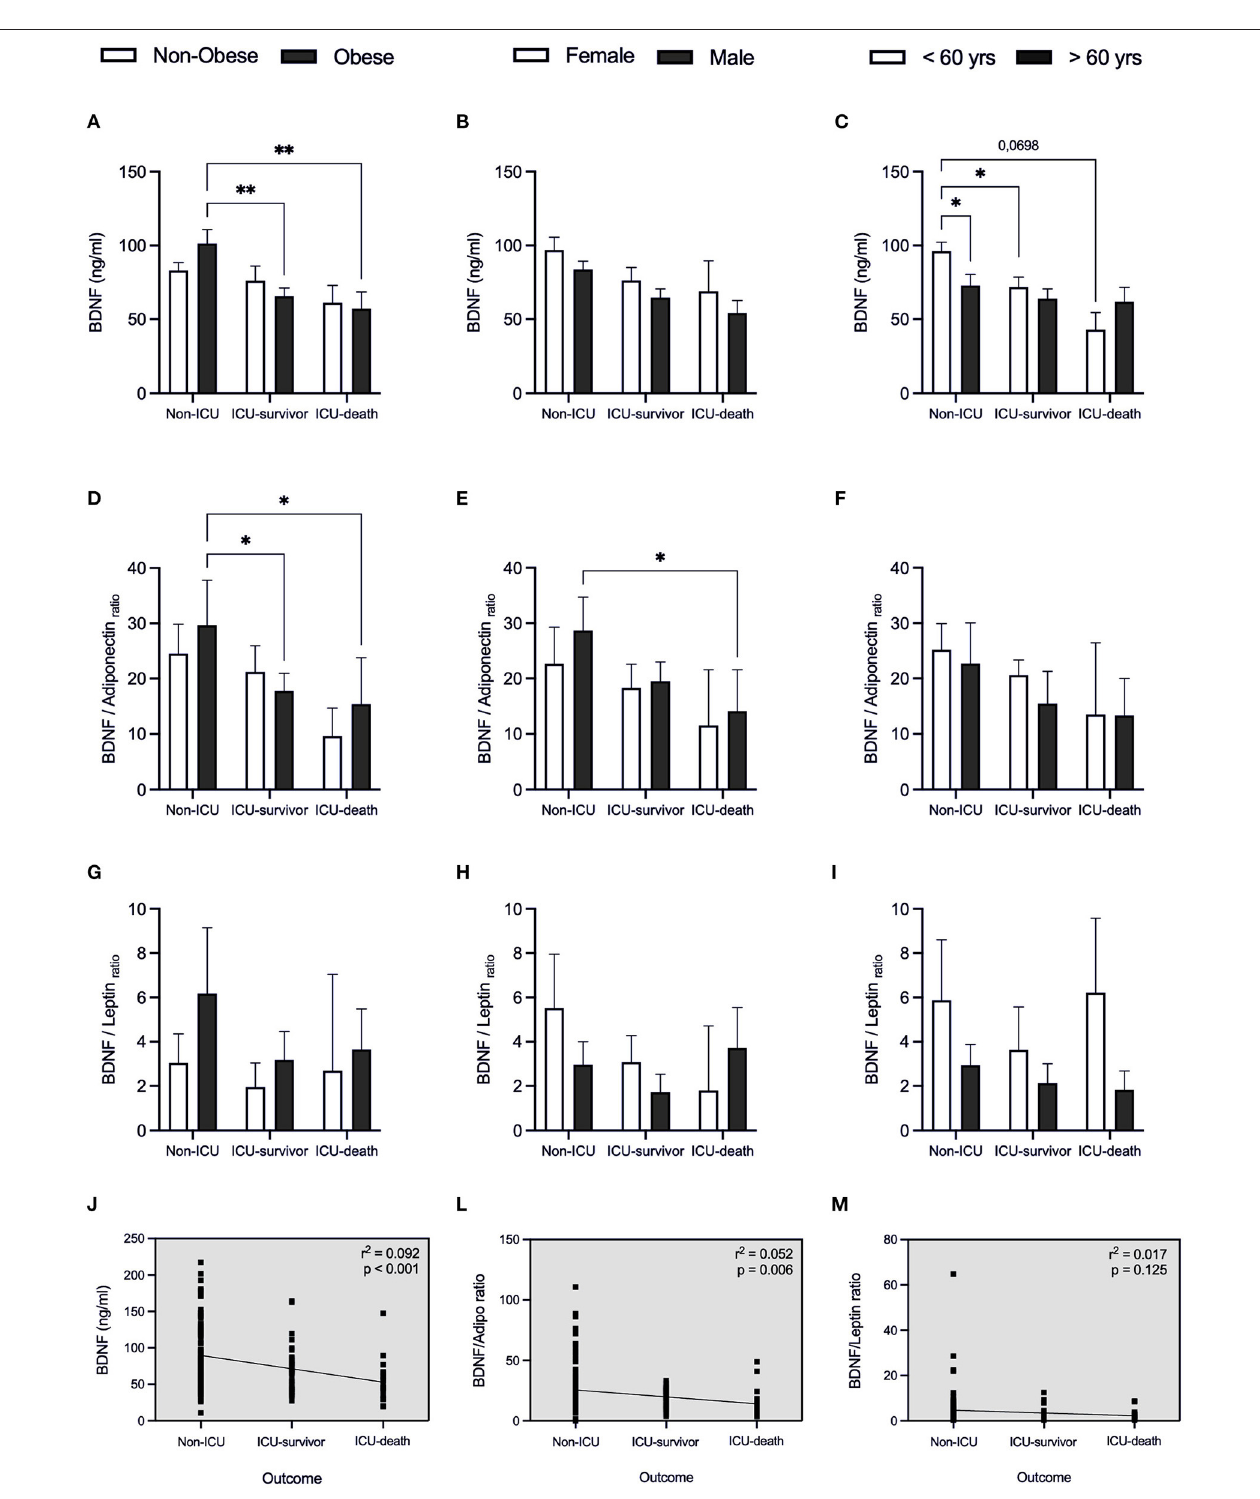
FIGURE 5 | BDNF and BDNF-related ratios for patients with COVID-19 in relation to clinical outcome. Values expressed as mean with 95% Confidence Interval for patients that were hospitalized without intensive care (Non-ICU), patients admitted to the intensive care unit and discharged (ICU-survivor) and patients who died (ICU-death), including: BDNF (A–C) , BDNF/adiponectin ratio (D–F) , and BDNF/leptin ratio (G–I) related to body index mass (BMI), sex and age, respectively. Dashed box presents linear regression curve of adiponectin (J) , leptin (L) , and adiponectin/leptin ratio (M) as dependent variable (Y axis) with outcome as independent variable (X axis). Significance: * p < 0.05; ** p <